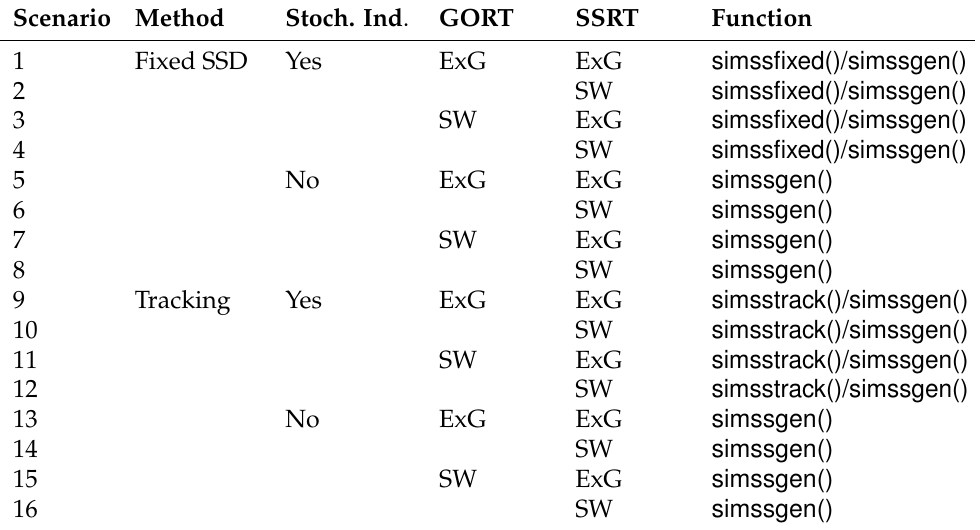
Table 2. A summary of potential simulation scenarios by R package “SimSST” (version